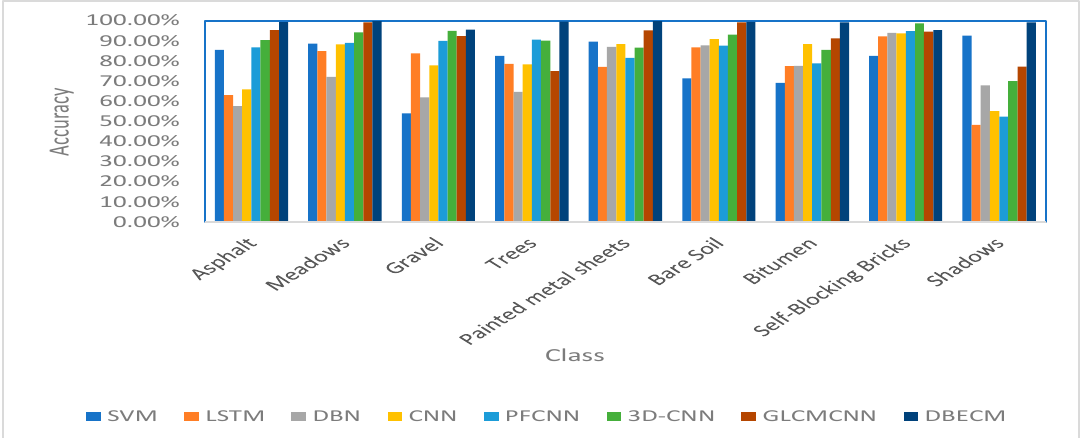
Figure 10. Accuracy in different methods. Remote Sens. 2020 , 12 , x FOR PEER REVIEW